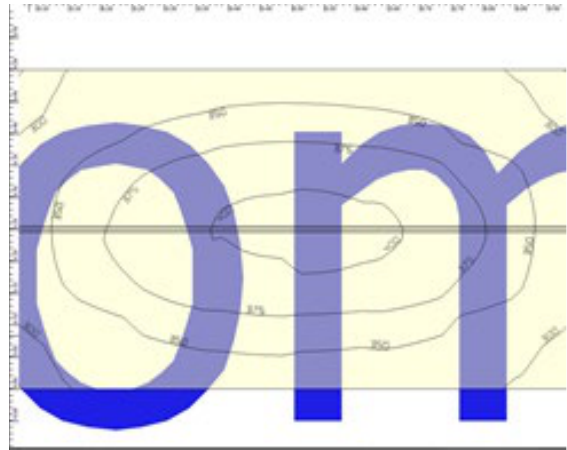
Fig. 2. Lighting scheme for classroom type occupied